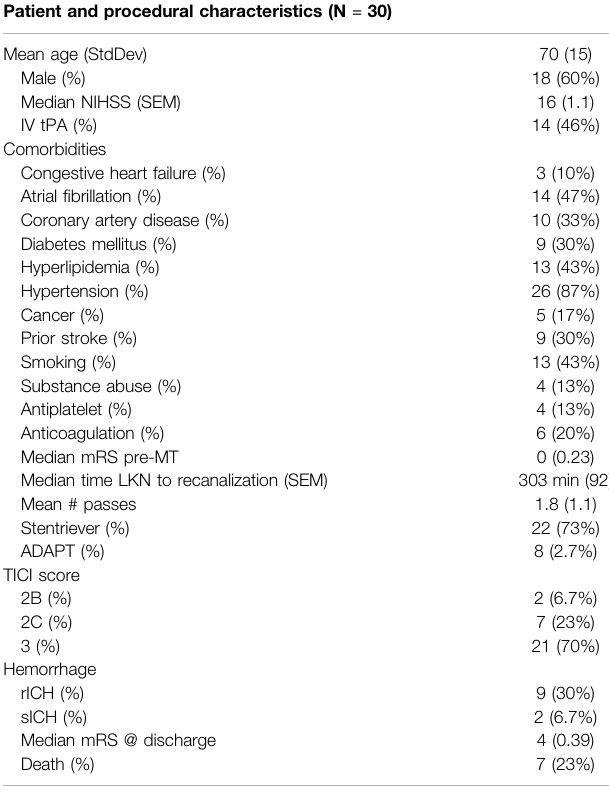
TABLE 1 | Baseline characteristics of patients who underwent mechanical thrombectomy. Patient and procedural characteristics (N =